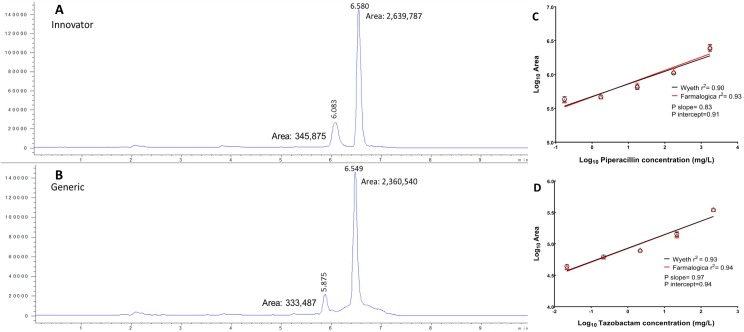
LC/MS comparison and pharmaceutical equivalence of innovator (Wyeth) and generic (Farmalogica) TZP.Panels A and B display the chromatograms of freshly reconstituted innovator and generic TZP, at the highest tested concentration (1740 mg/L of piperacillin and 217.5 mg/L of tazobactam). The small peak corresponds to tazobactam and the highest peak to piperacillin. The retention times, peak magnitudes and areas of both products were very similar. Panels C and D show the standard curves of piperacillin and tazobactam. The regression analysis comparing slopes and intercepts indicated that a single curve described both innovator and generic products, which are therefore pharmaceutically equivalent.